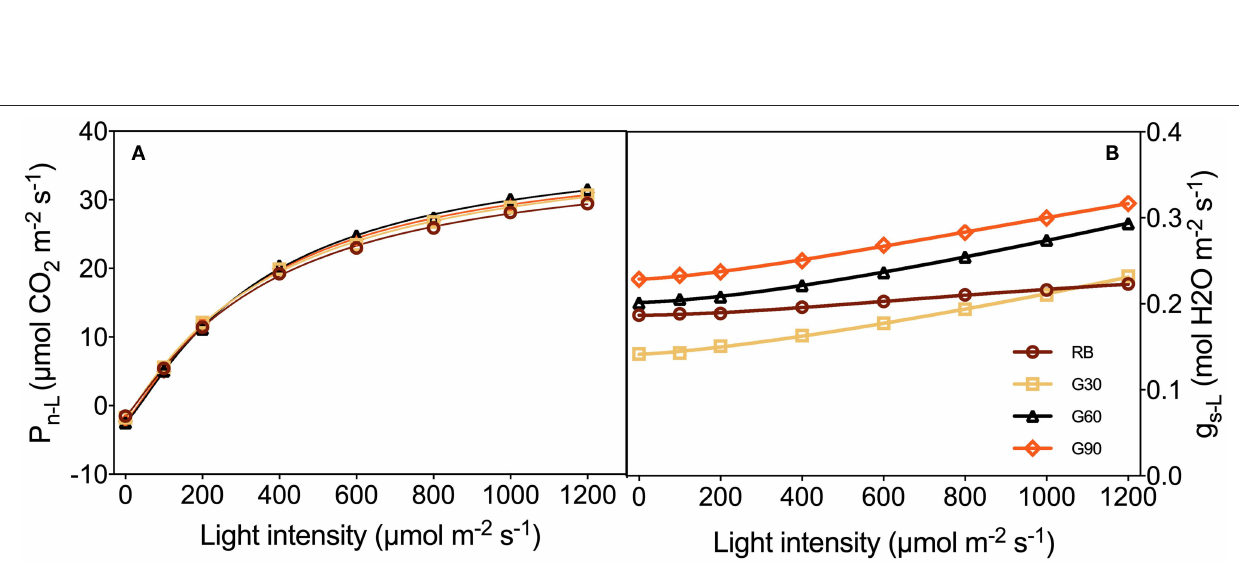
Frontiers in Plant Science |